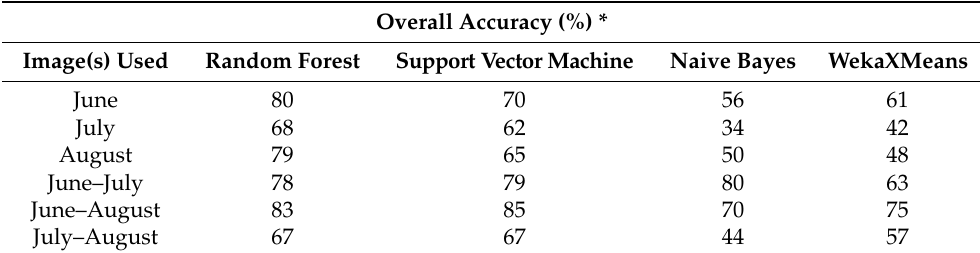
Table 10. DESIS Overall Accuracies. Overall classification accuracies for three leading world crops (corn, soybean, and winter wheat) from four classification algorithms (Random Forest, Support Vector Machine, Naive Bayes, and WekaXMeans) using 29 DESIS hyperspectral narrowbands. Analysis was conducted for June through August 2019.